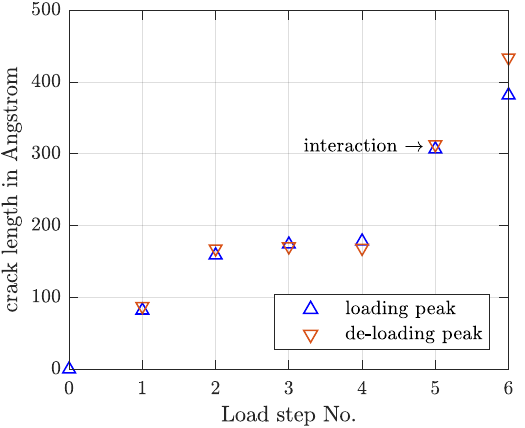
Figure 11. Single over-load